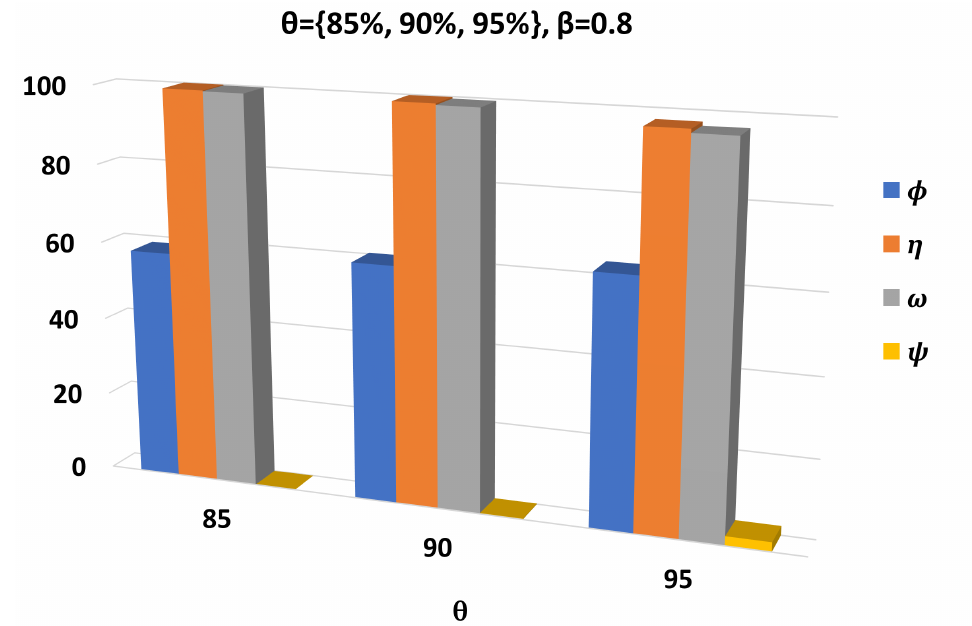
Figure 9. Comparison of UPSHM performances for all metrics for different values of the θ